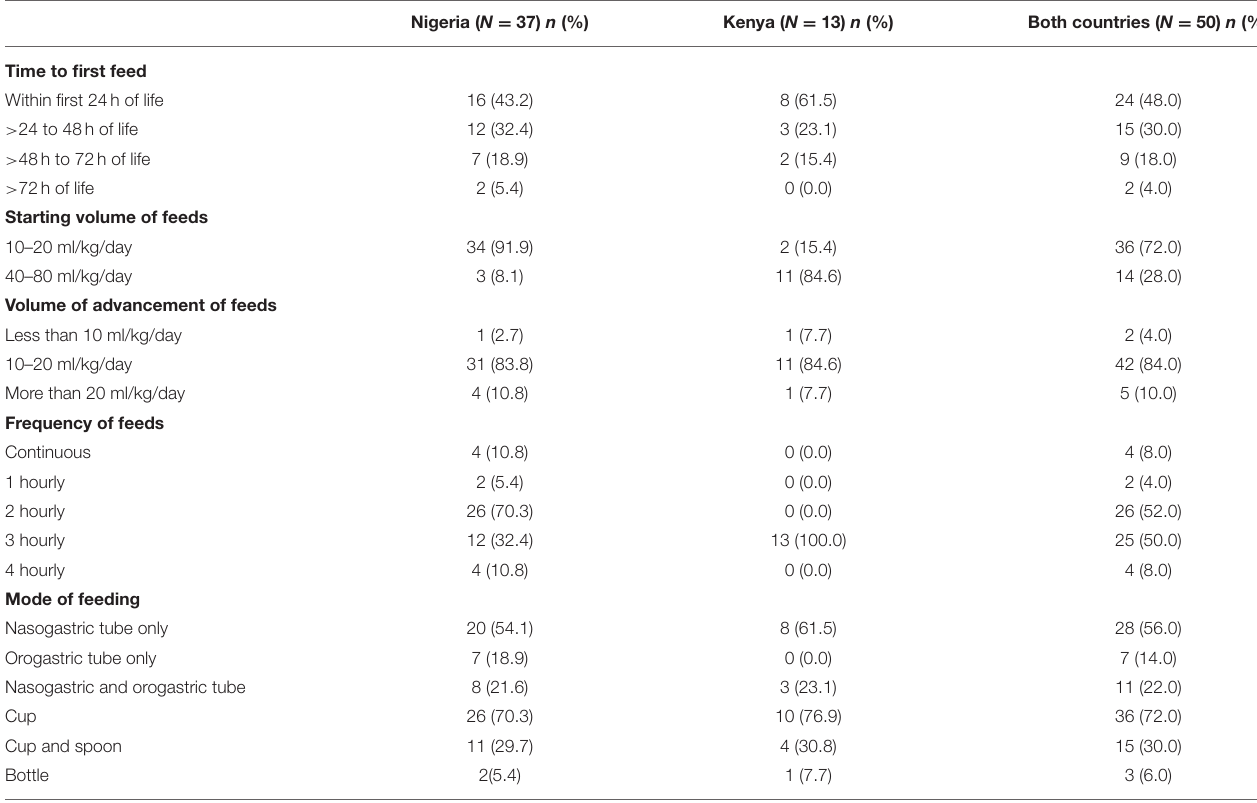
TABLE 3 | Reported feeding